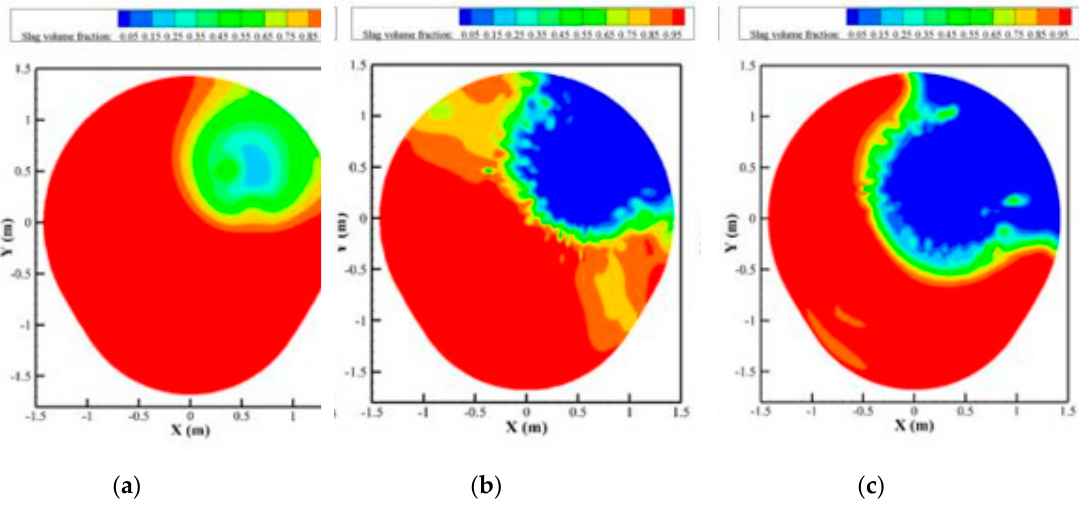
Figure 10. Open-eye size in the ladle from experimental results for a slag layer thickness of 55 cm: ( a ) Q = 200 NL/min, ( b ) Q = 400 NL/min, and ( c ) Q = 500 NL/min.